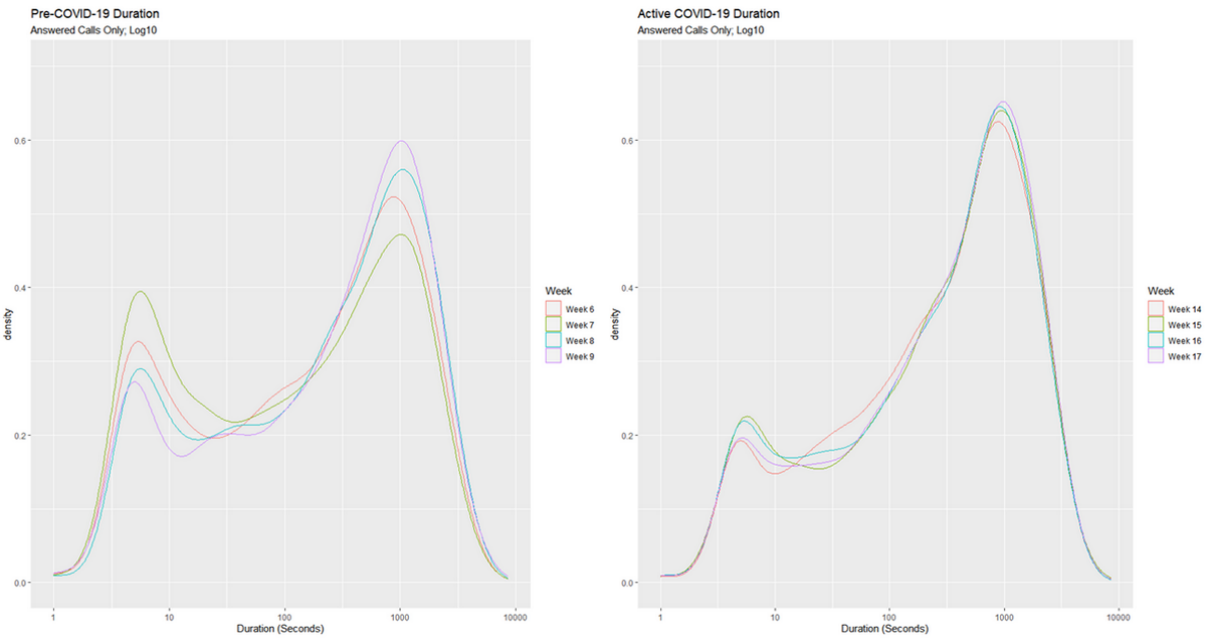
Figure 3. Densities of call durations of answered calls by week within the Pre–COVID-19 period (left) and Active COVID-19 period (right).